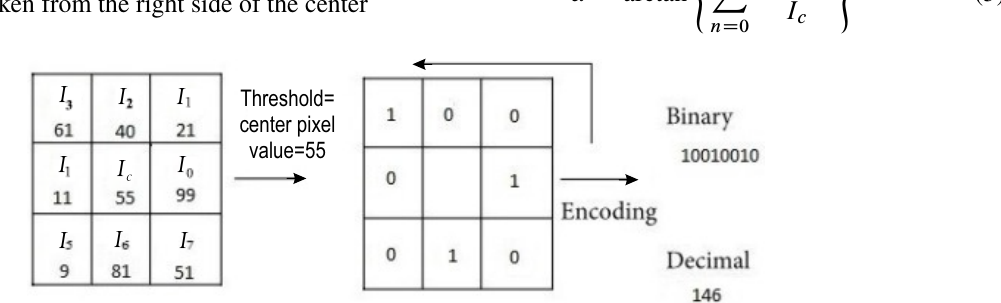
Fig. 3 LBP code generation procedure of the center